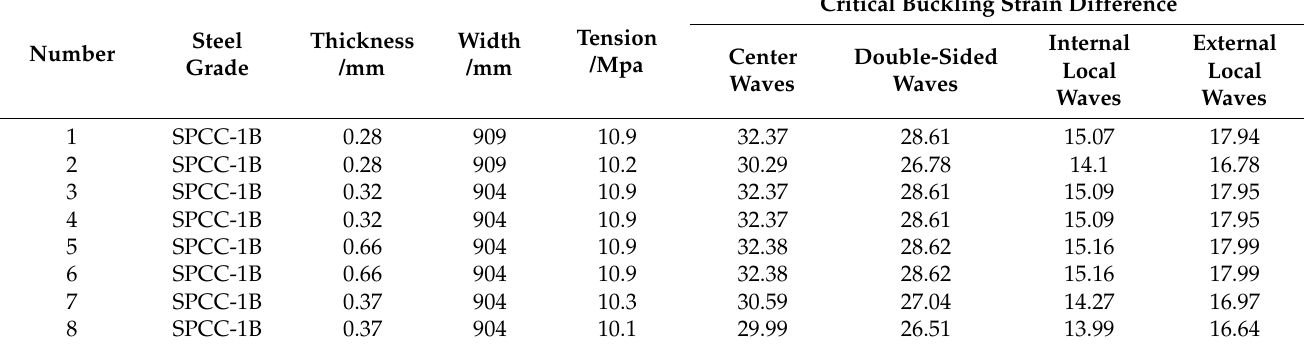
Table 2. Cold rolling site sample data.